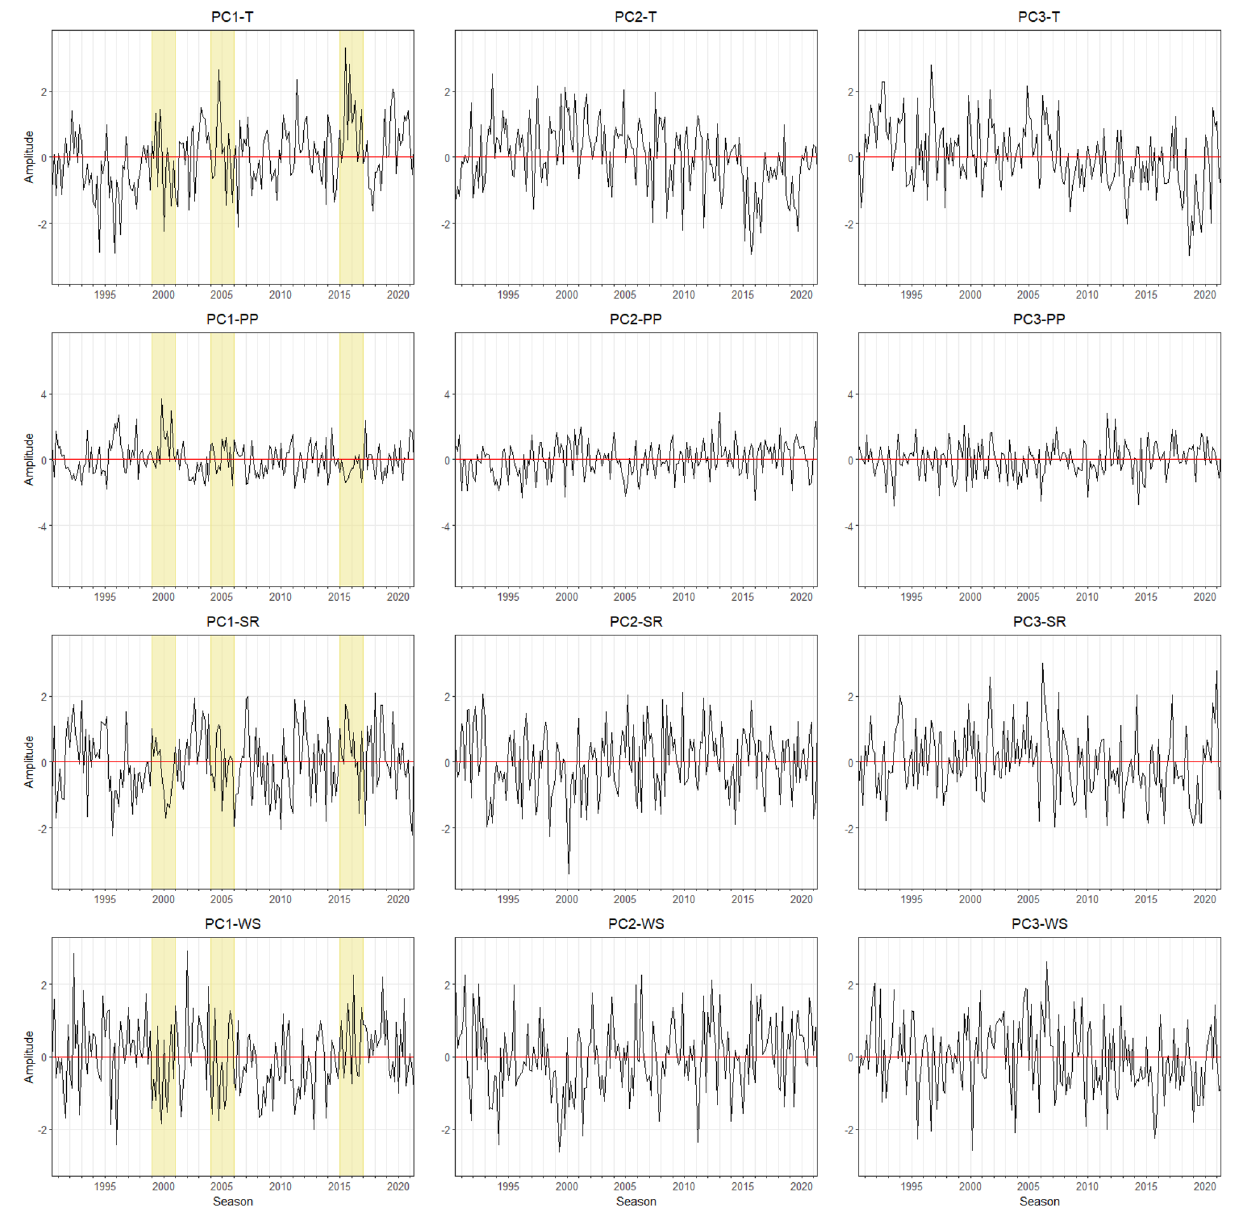
Figure 5. Monthly time series of growing season patterns in maize growing season (principal components, PC) corresponding to EOF-1, EOF-2, and EOF-3 for the KwaZulu-Natal province (see Fig. 4). Strong positive or negative anomalies of the dominant mode are highlighted (extreme events). The x-axis ticks indicate the beginning period of growing season. The abbreviations of agrometeorological data (T, PP, SR, WS) refer